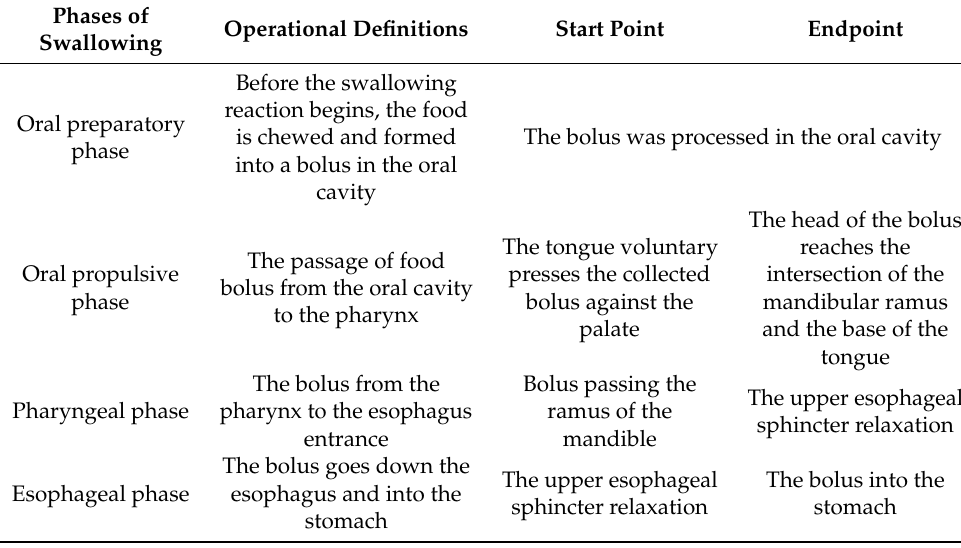
Table 1. Operational definitions of different phases of